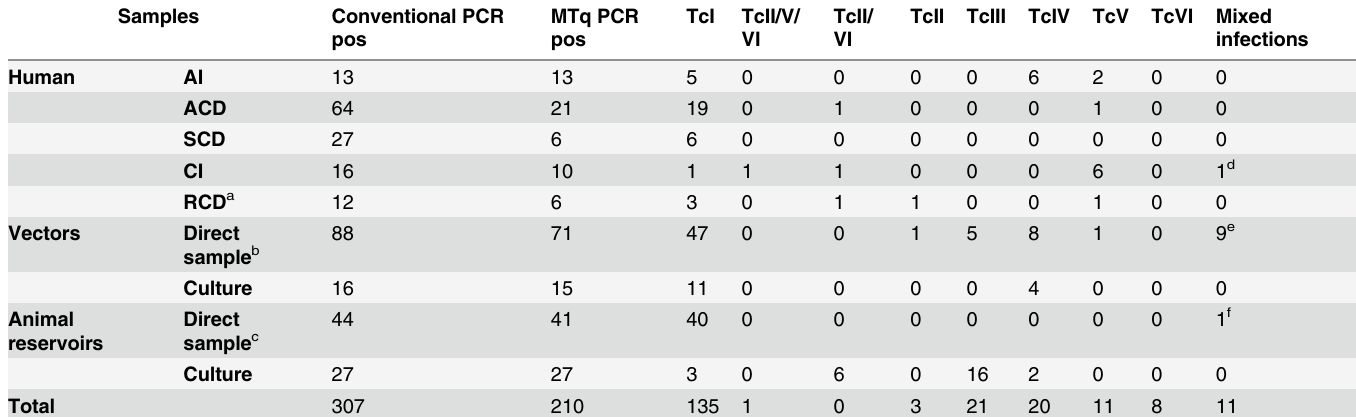
Table 4. Multiplex real-time PCR genotyping algorithm validation with biological samples. Samples